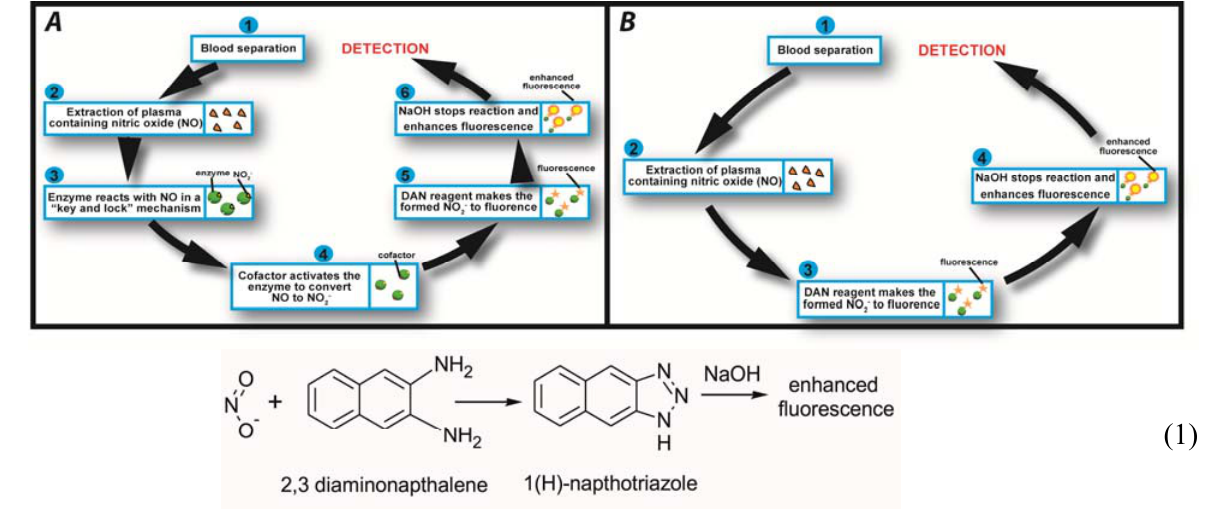
Figure 2. ( A ) Sequence of the homogeneous nitrate+nitrite assay (disc 1) Step 1: Separation of blood plasma; Step 2: Plasma containing nitric oxide (NO) is extracted from the blood separation chamber; Step 3: Enzyme (nitrate reductase) specifically reacts with NO in the extracted plasma; Step 4: Cofactor activates the enzyme to convert NO to NO 2 − ; Step 5: DAN reagent reacts with the formed NO 2 − to produce fluorescence and finally Step 6: NaOH is added to stop the enzymatic reaction and enhance fluorescence for off-disc read-out using a fluorescence analyser ( B ) Nitrite assay (disc 2). The steps are